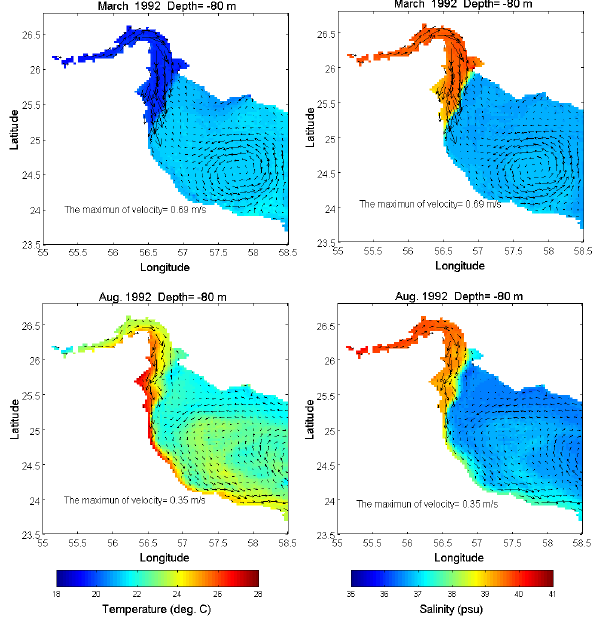
Fig. 15. Horizontal mean fields of temperature (left) and salinity (right) in extended view of the Strait of Hormuz and Oman Sea at depth 80m during March and August.